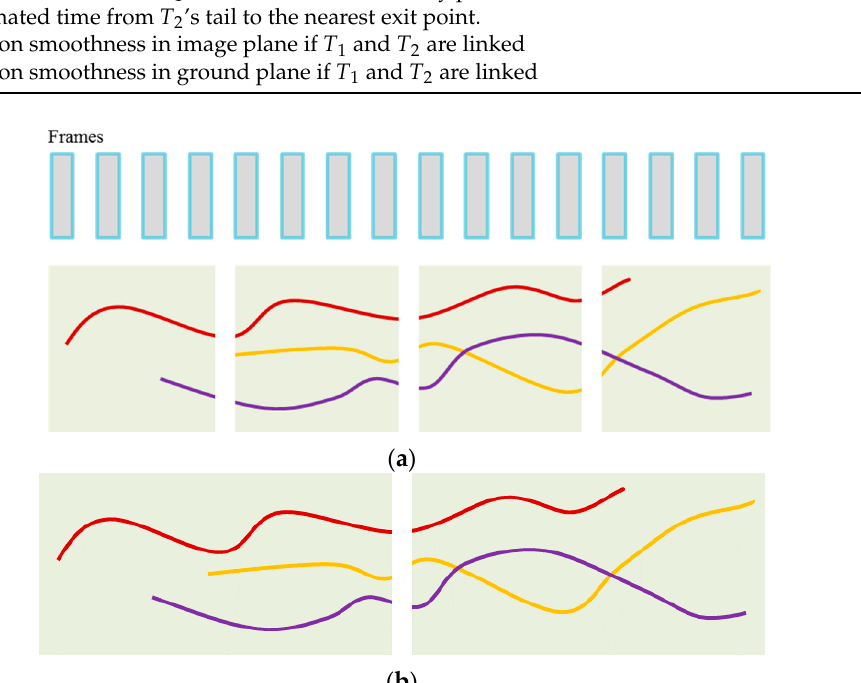
Figure 4. Two-stage training procedure: ( a ) 1st stage: Maximum length of tracklets is 1/4 of the whole image sequences for training; ( b ) 2nd stage: Maximum length of tracklets is 1/2 of whole image sequences for training.